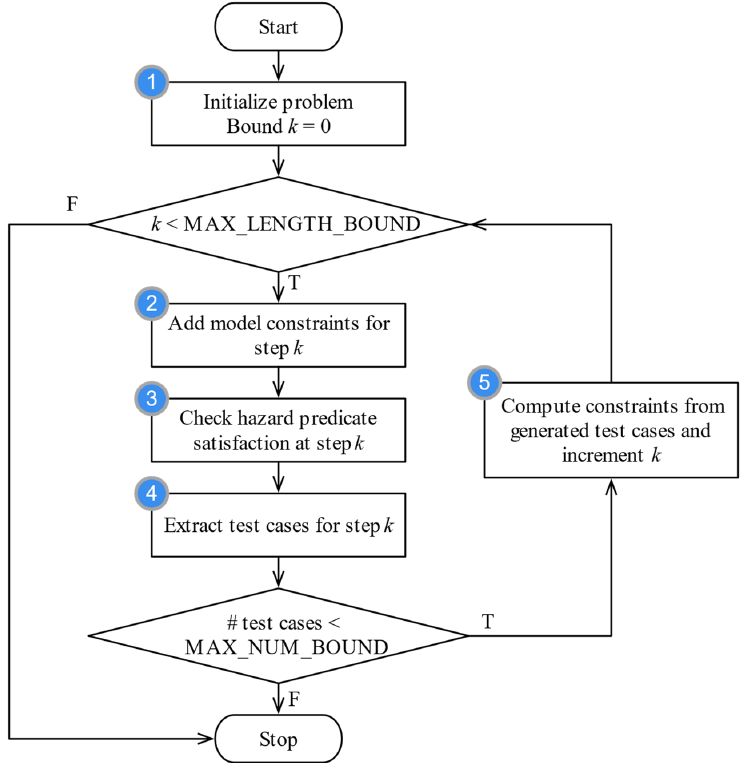
Figure 2. Flowchart of ATG algorithm supporting the test case generation.